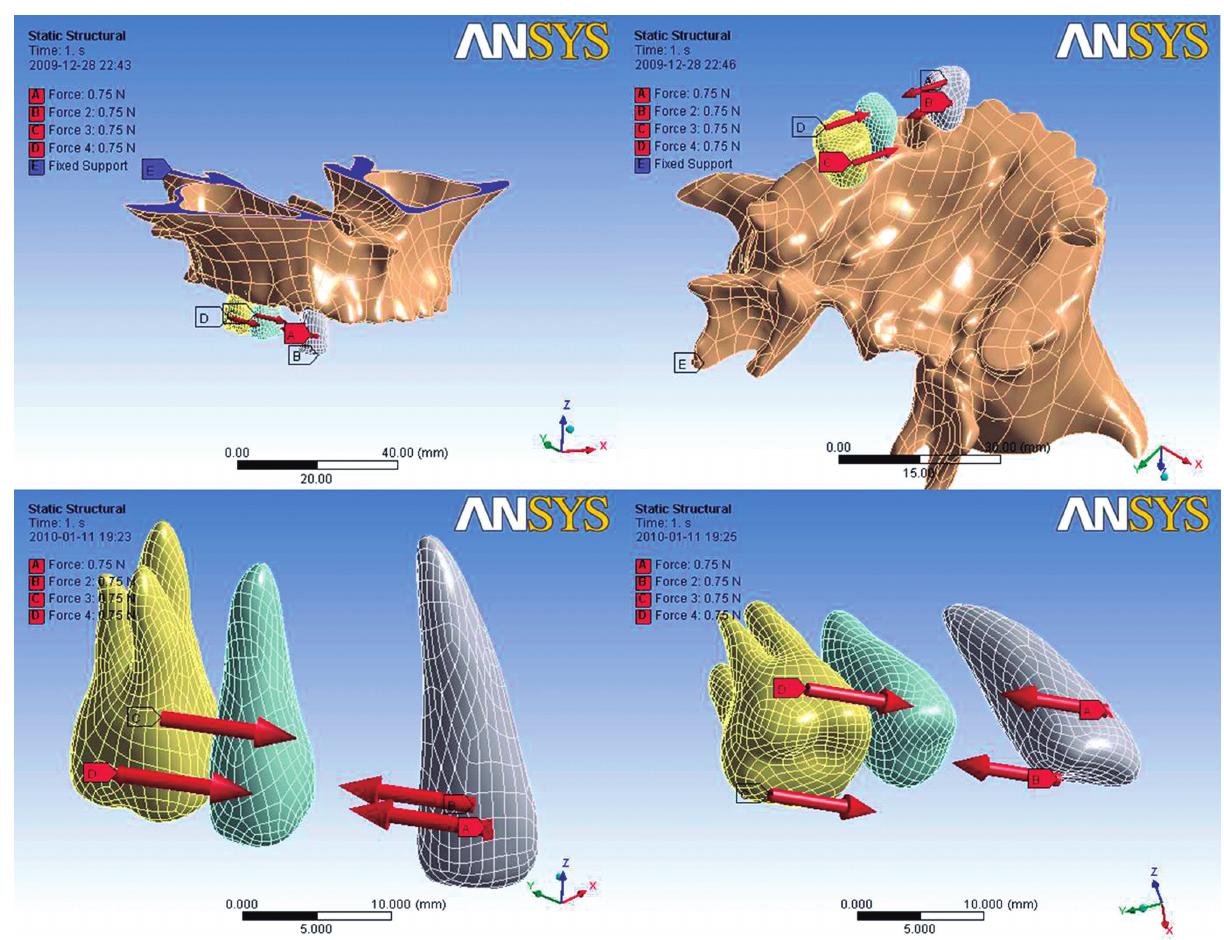
Figure 6- The coordinate system. A mesiodistal simulated retraction force of 1.5 N was loaded bilaterally to the center of the crown between the first molar and the